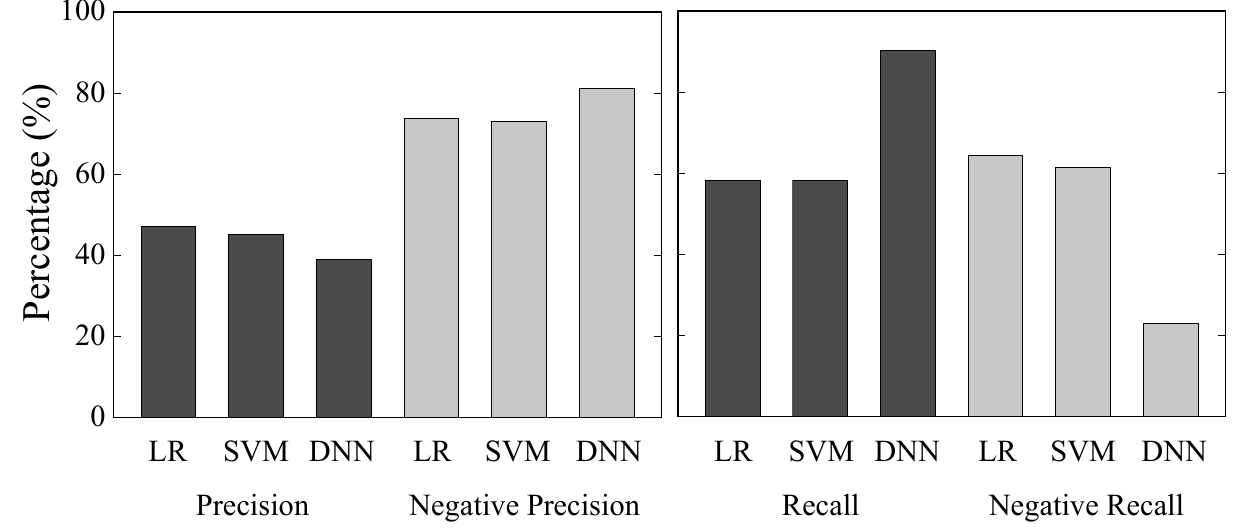
Figure 10. Comparison of Precision, Negative Precision, Recall, and Negative Recall in Section 3.7.